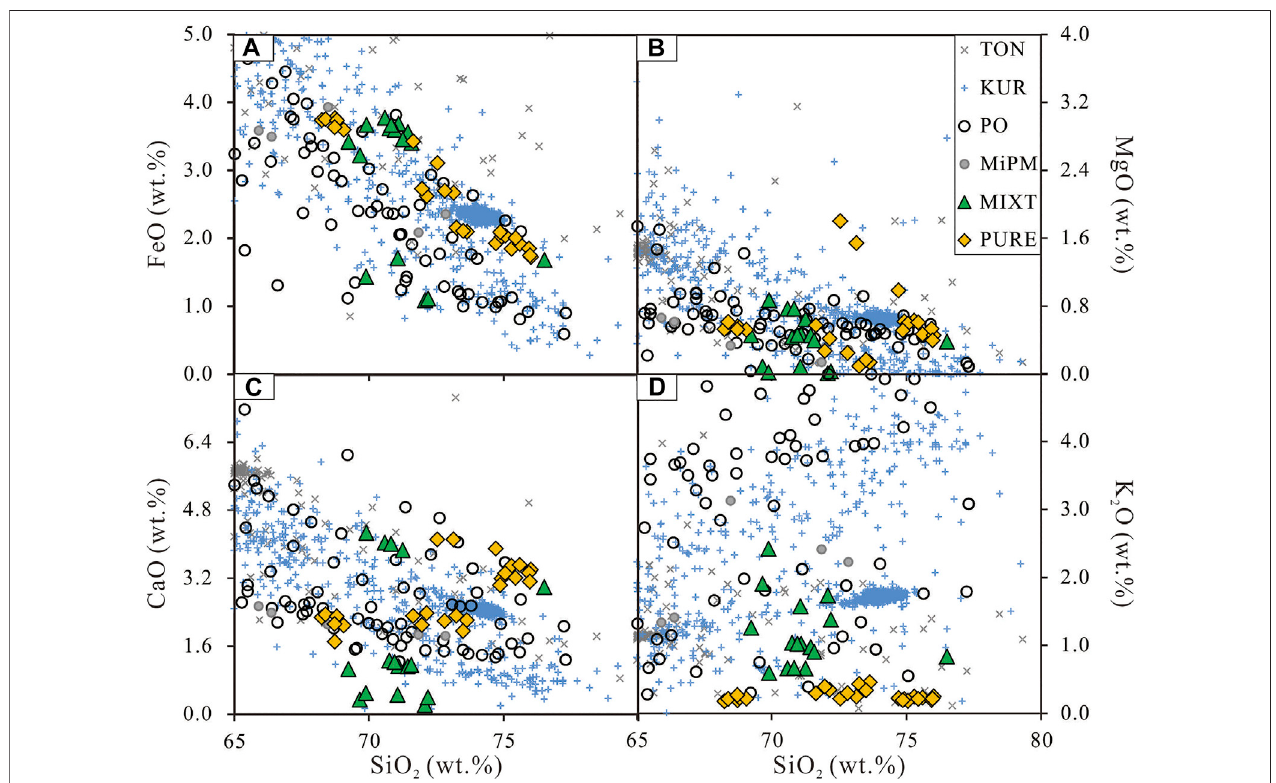
FIGURE9| Harkerdiagramsofmeltsfrompartialmeltingexperimentand fi ledobservation.TON,KUR,andMiPMarethesamewith Figure1 ontheirmeaningand data; PO, melts from partial melting experiments of pure basic rocks, the data including BaDE, AmPM, and GaPM in Figure 1 ; PURE and MITX are same to Figure 4 .